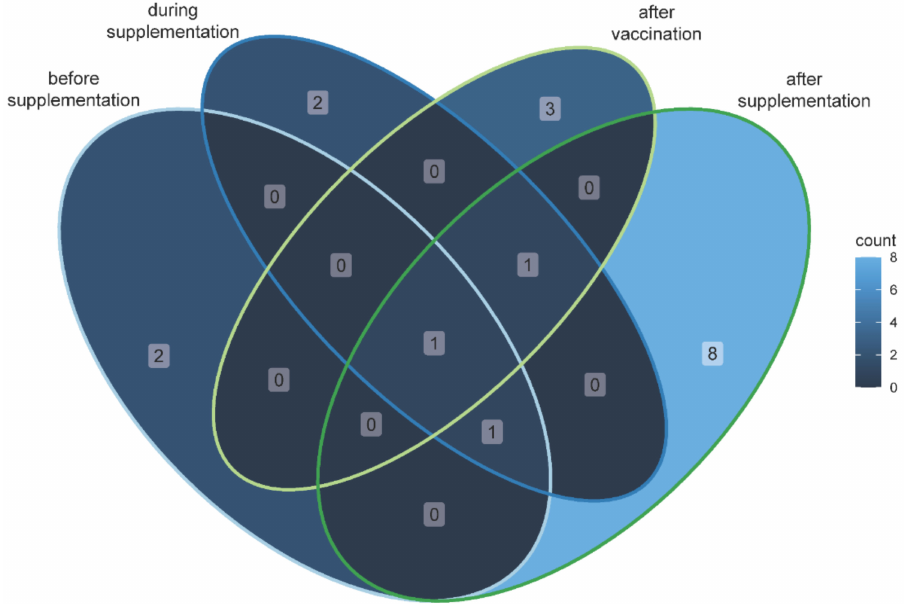
Figure 4. Venn diagram showing significantly different OTUs (selected with a criterion of FDR- adjusted p -values < 0.05 and absolute log2 fold change > 1) between horses belonging to the two groups PLA and OLI that are shared among the experimental